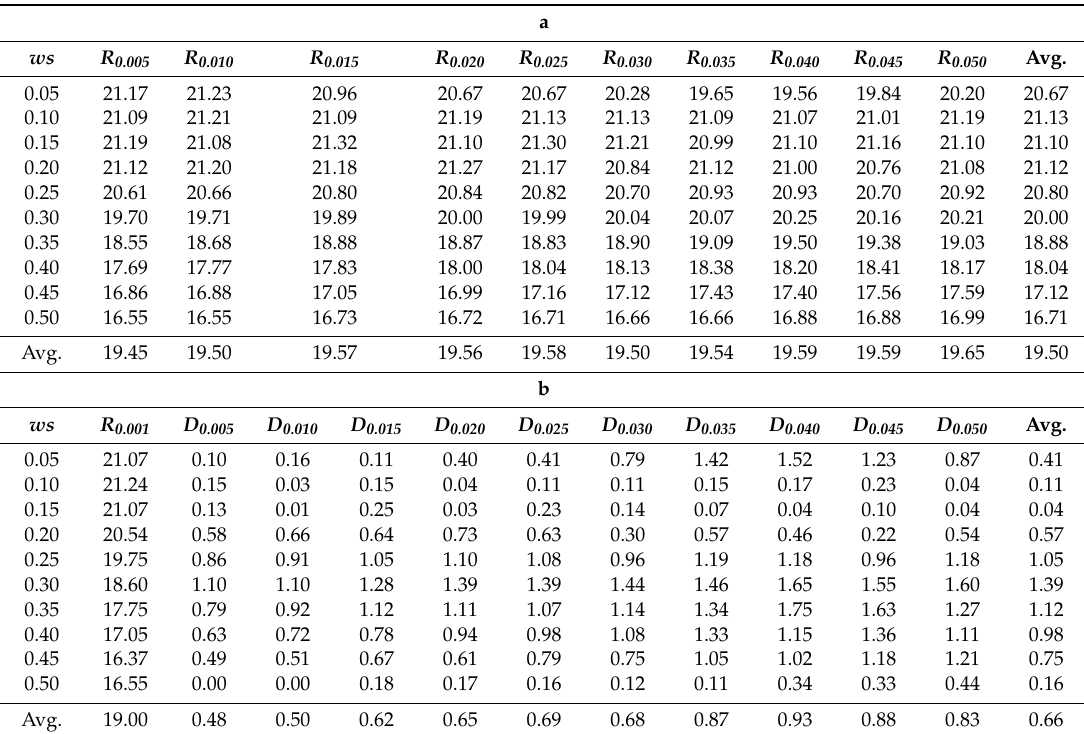
Table 3. (a) The R values with di ff erent windows sizes ( ws ) and di ff erent step sizes ( θ ) for the group 3 data, where R 0.005 denotes the obtained values of Rs when θ is set to 0.005. (b) The deviation matrix compared to the baseline